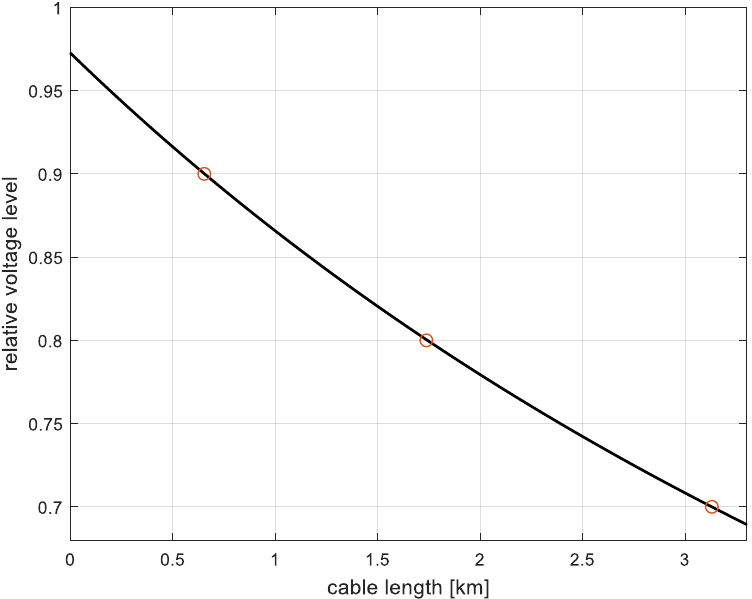
Figure 2. Dependence of the startup voltage level on cable length in the whole analyzed range.